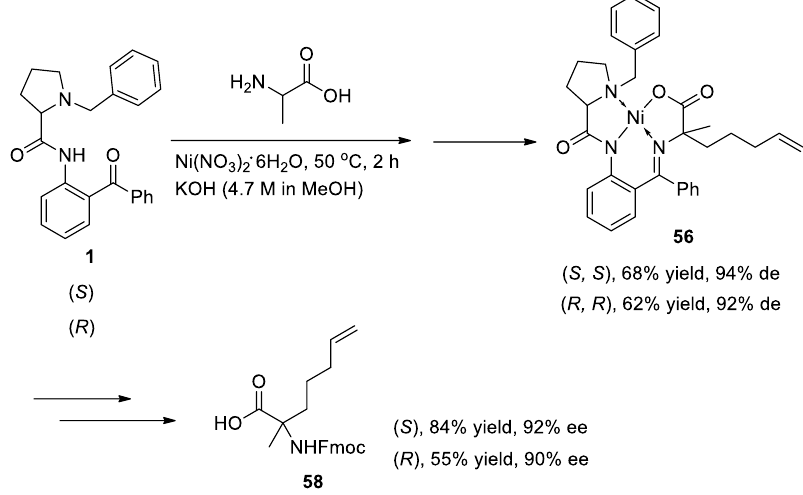
α , α -disubstituted amino acid derivatives. Scheme 21. An improved synthesis route to α,α -disubstituted amino acid